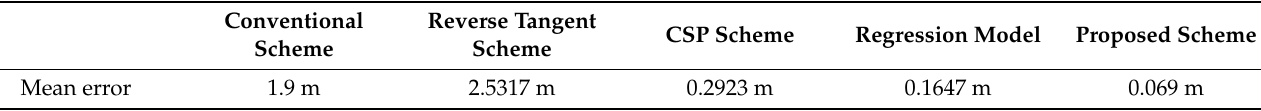
Table 4. Comparison of the average error between the conventional schemes and the proposed scheme.